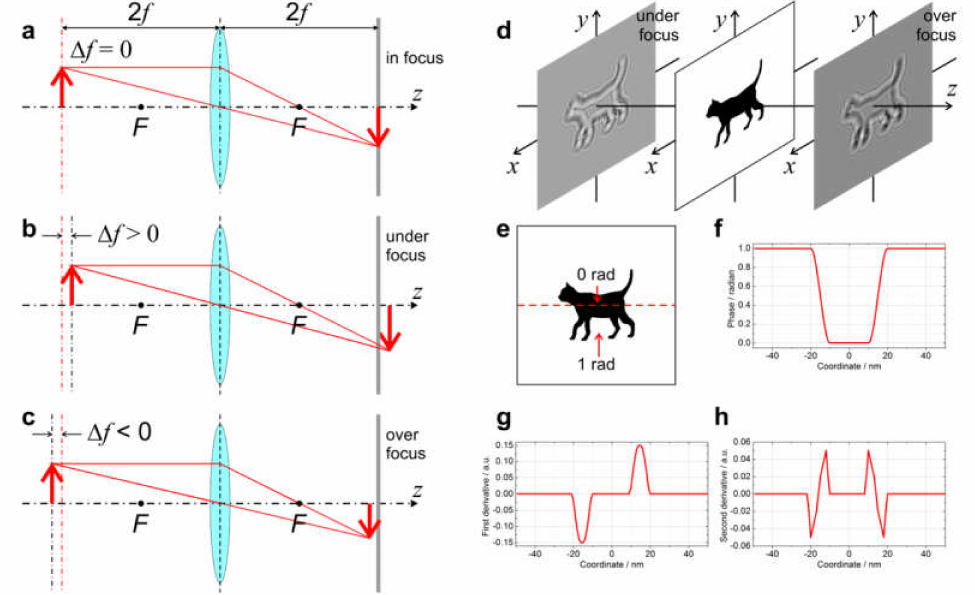
Figure 15. Defocused imaging in TEM. ( a – c ) Ray diagrams of a lens system when imaging ( a ) in focus, ( b ) under focus, and ( c ) over focus. The detector is at the same position in all three cases. The position of the object is shifted along the optical axis in ( b ) by ∆ f > 0 and in ( c ) by ∆ f < 0, and as a result, the image on the detector appears under-focused in ( b ) and over-focused in ( c ). ( d ) Under- and over-focused images of a pure phase object, a cat-shaped hole in a carbon film with the phase distribution shown in ( e ). ( f – h ) show profiles through the middle of the 2D distribution of ( f ) the sample, ( g ) its first derivative, and ( h ) its second